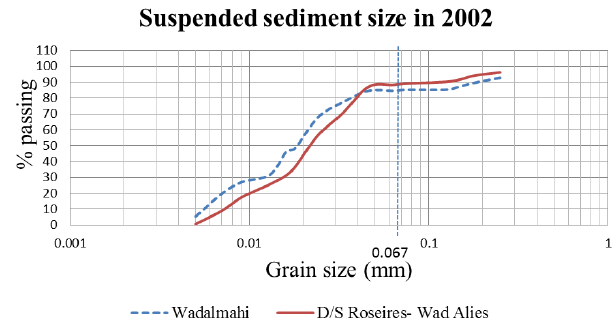
Figure 4. Suspended sediment grain size distributions inside Ro- Fig. 4. Suspended sediment grain size distributions insideRoseires Reservoirat Wad El seires Reservoir at Wad El Mahi (location in Fig. 2) and downstream Mahi (location in Fig. 2) and downstream of Roseirs Dam (Source: MoIWR). of Roseires Dam (source: